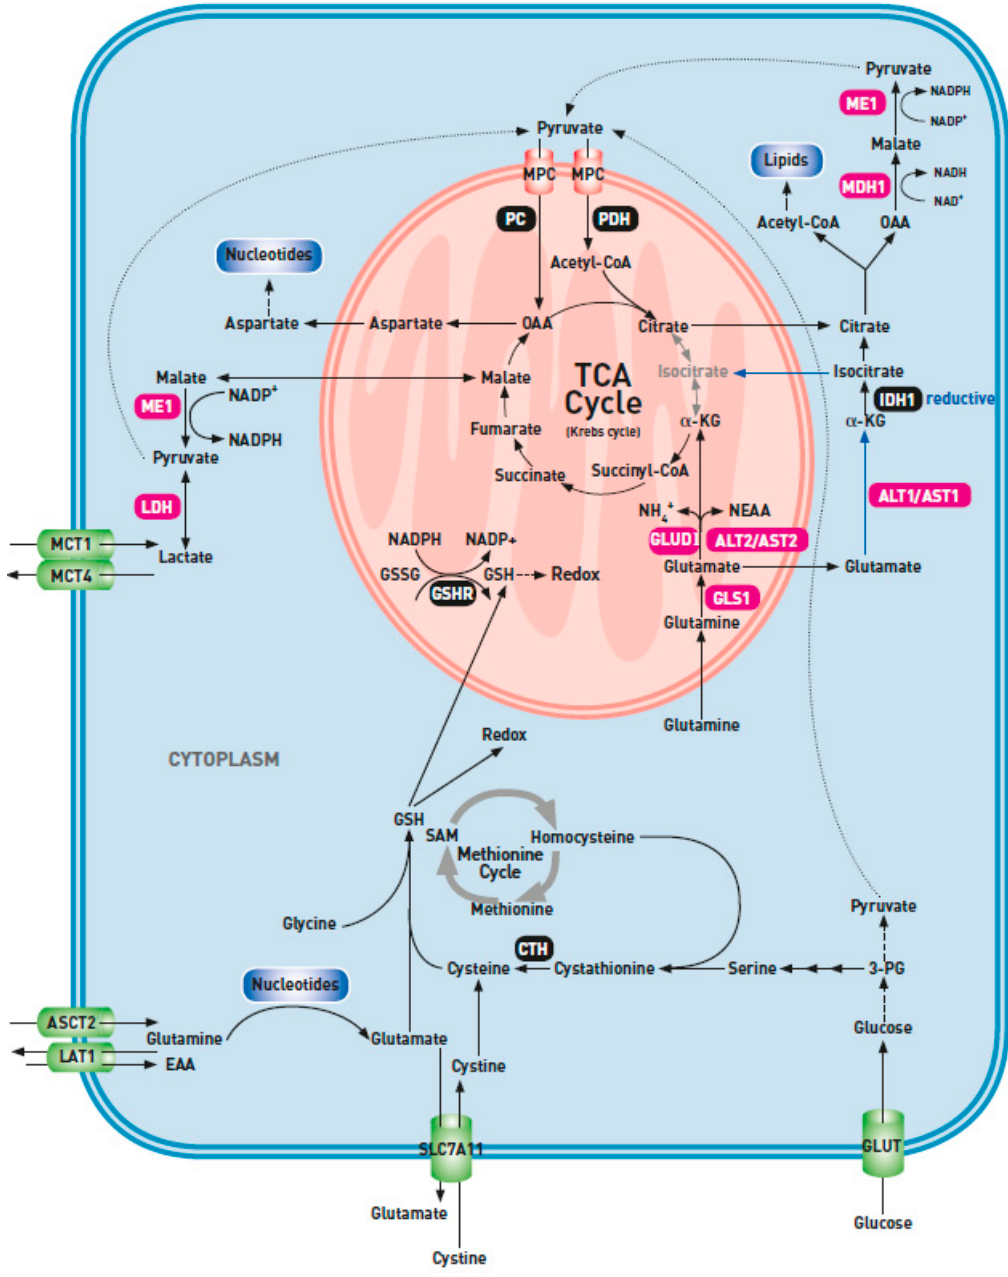
Figure 1. Glutamine metabolism in cancer cells. ALT, alanine aminotransferase; ASCT2, alanine-serine-cysteine-transporter-2; AST, aspartate aminotransferase; CTH, cystathionine gamma-lyase; EAA, essential amino acids; GLS, glutaminase; GLUD, glutamate dehydrogenase; GLUT, glucose transporter; GSH, reduced glutathione; GSHR, glutathione reductase; GSSG, oxidized glutathione; IDH, isocitrate dehydrogenase; α -KG, α -ketoglutarate; LAT1, ʟ -type amino acid transporter; LDH, lactate dehydrogenase; MCT, monocarboxylate transporter; MDH, malate dehydrogenase; ME, malic enzyme; MPC, mitochondrial pyruvate carrier; NADPH, reduced nicotinamide adenine dinucleotide phosphate; NH 4+ , free ammonia; OAA, oxaloacetate; PC, pyruvate carboxylase; PDH, pyruvate dehydrogenase; PG, phosphoglycerate; SAM, S -adenosylmethionine; SLC7A11, solute carrier family member 7A11 (xCT). Glutaminolysis in